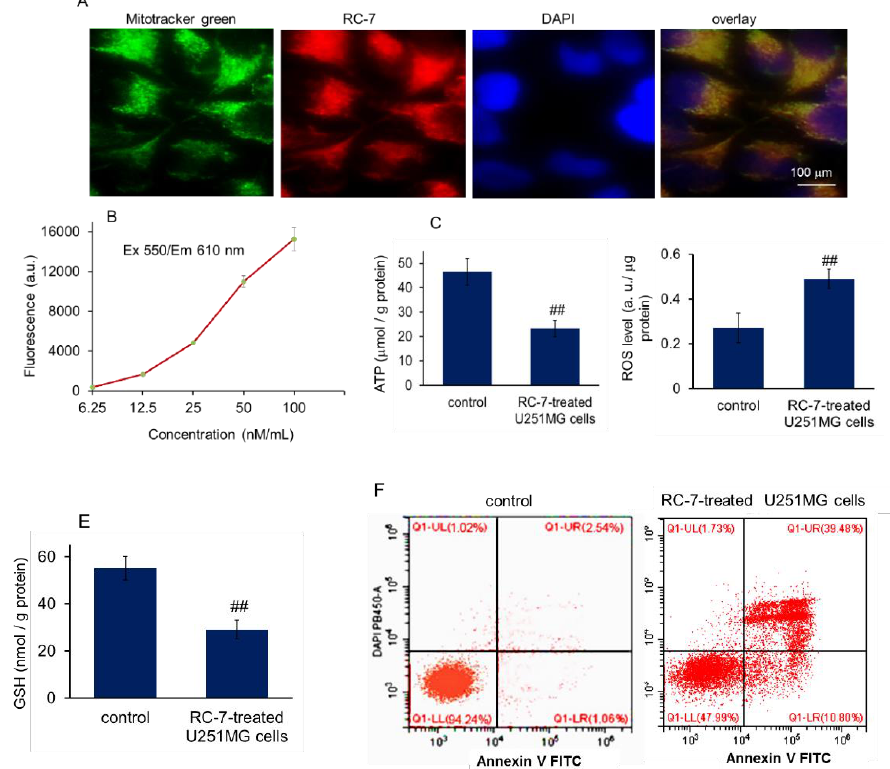
Figure 3. RC-7 induced U251MG cell apoptosis after arriving in mitochondria. ( A ) Intracellular distribution of RC-7 in U251MG cells. Cells were incubated with 50 nM RC-7 (red) for 2 h, followed by staining of mitochondria with MitoTracker green and the cells were observed with the confocal microscope. ( B ) Concentration-fluorescence intensity curve of RC-7 in U251MG cells. The fluorescence intensity increased in a RC-7 concentration-dependent manner. The data were expressed as mean SEM. Three independent experiments were performed. In addition, ATP ( C ), ROS ( D ), and GSH ( E ) were respectively determined in the RC-7 treated U251MG cells. ( F ) Cell apoptosis was measured by flow cytometry. The U251MG cells treated by RC-7 were collected and stained by Annexin V-FITC and DAPI for cell apoptosis assay.